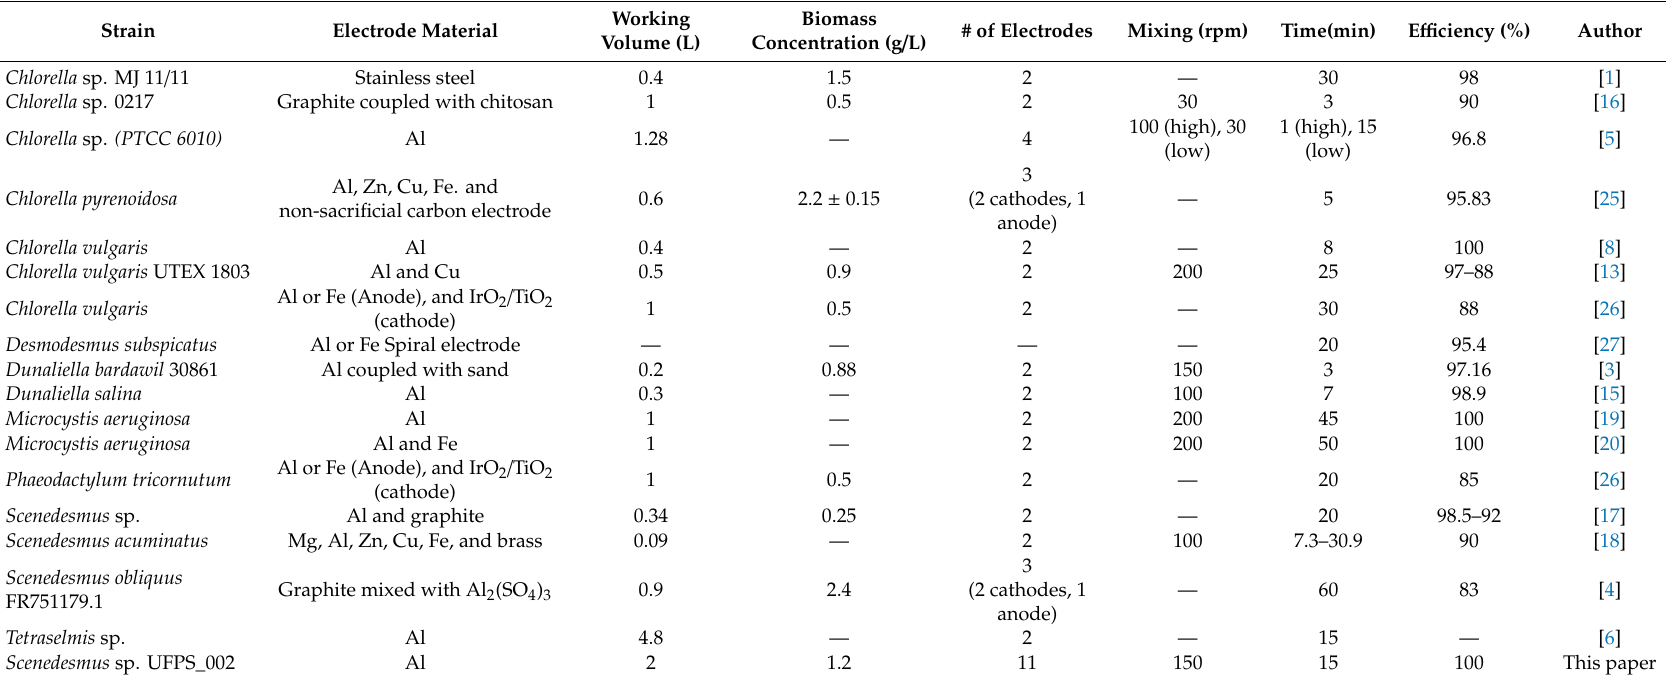
Table 3. Electrode materials evaluated for the harvesting of microalgae and